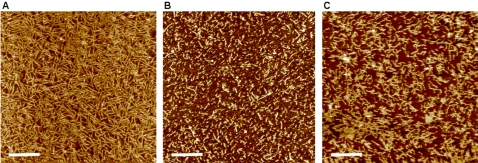
AFM images of the peptide nanostructures: (a) EAK16-II; (b) EAK16-IV; (c) EFK16-II.The peptide concentration is 0.5 mg/mL. The scale bar is 200 nm.